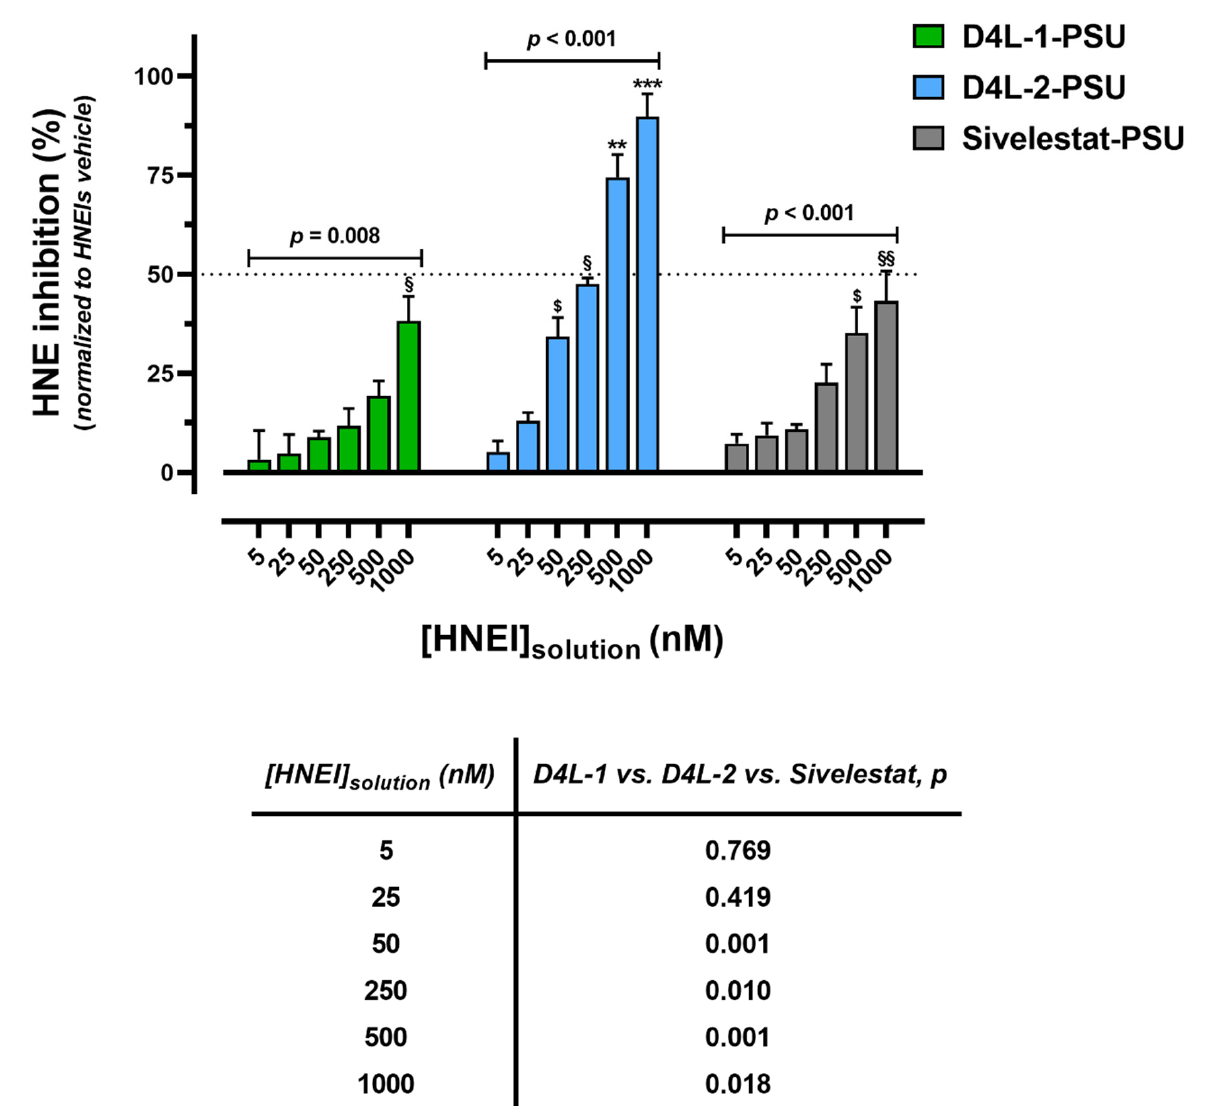
Figure 2. Human neutrophil elastase (HNE) inhibition of D4L-1-PSU, D4L-2-PSU, and Sivelestat-PSU doped membranes by adsorption (25 ◦ C, 3 h), assessed by the HNE activity assay. Data obtained from 3 independent experiments (performed in triplicate) are presented as mean ± SEM (standard error of the mean). Dotted line represents the IC50 value of the respective HNEI in HEPES 0.1M, pH 7.4 buffer. Brackets denote the statistical analysis results of comparison of HNEI-PSU membranes incubated with the respective initial solution concentration of each HNEI (one-way ANOVA test), ** p < 0.01, *** p < 0.001 between that HNEI solution and all the preceding concentrations; § p < 0.05, §§ p < 0.01 between 1000 nM and 5/25 nM; $ p < 0.05, between 50 nM and 5 nM. (Bonferroni post hoc test) and the embedded table shows the comparison between D4L-1, D4L-2, and Sivelestat groups within each concentration (one-way ANOVA test); p < 0.05 was considered statistically significant. For each assay, HNE inhibition was standardized establishing that PSU membranes incubated with HNEIs’ vehicle (2.5% DMSO) samples corresponded to zero (minimum). HNEI, human